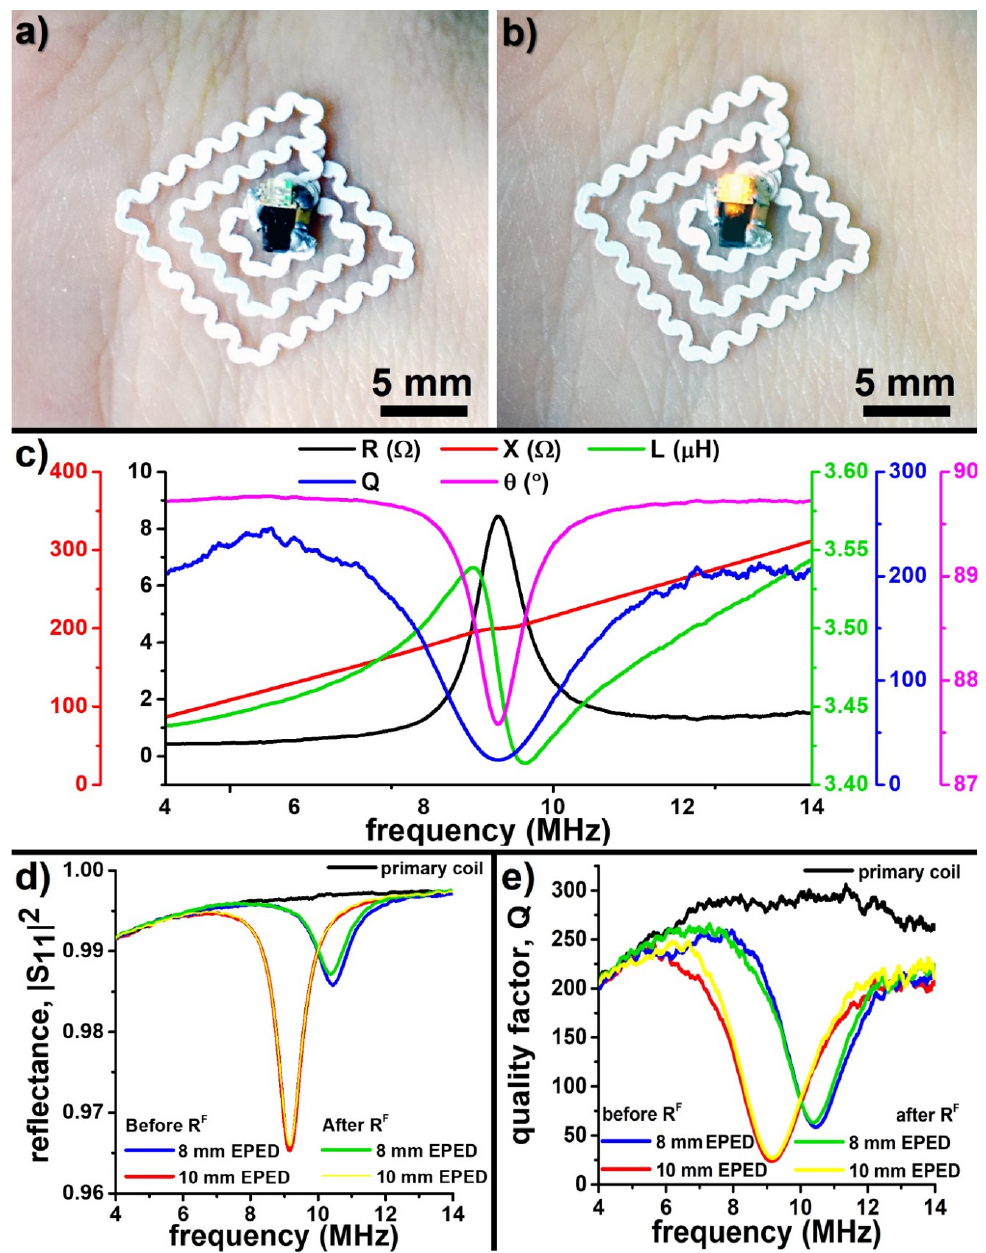
Figure 6. Electrical characteristics of wirelessly powered copper-based EPEDs: ( a ) Square EPED antenna (10 mm side) coupled with an SMD rectifier-LED circuit and attached to the skin of the wrist; ( b ) The LED is wirelessly powered using a primary coil 15 cm away (not shown in picture) running alternating currents at a resonant frequency of 9.0 MHz; ( c ) Frequency-dependent passive characteristics (Resistance, R, Reactance, X, Phase, θ, Inductance, L, and Quality factor, Q) of the EPED shown in ( a , b ). The frequency at which the phase θ is minimum is the resonant frequency of the EPED; ( d , e ) Effect of EPED size and silanization on the wireless power transfer efficiency (η = 1 − |S 11 | 2 ) and the quality factor (Q). The silanization process has a negligible effect on η and Q. η and Q decrease when the size of the EPED is reduced.